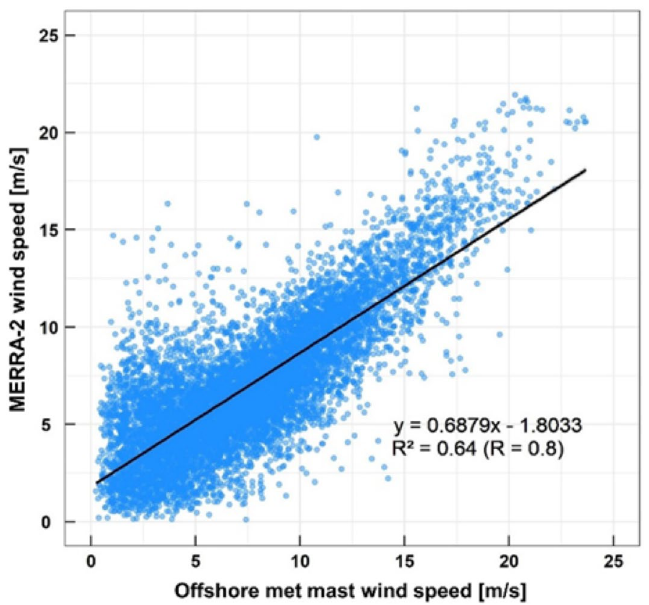
Figure 9. Comparison of concurrent wind speeds between MERRA-2 and offshore met mast.